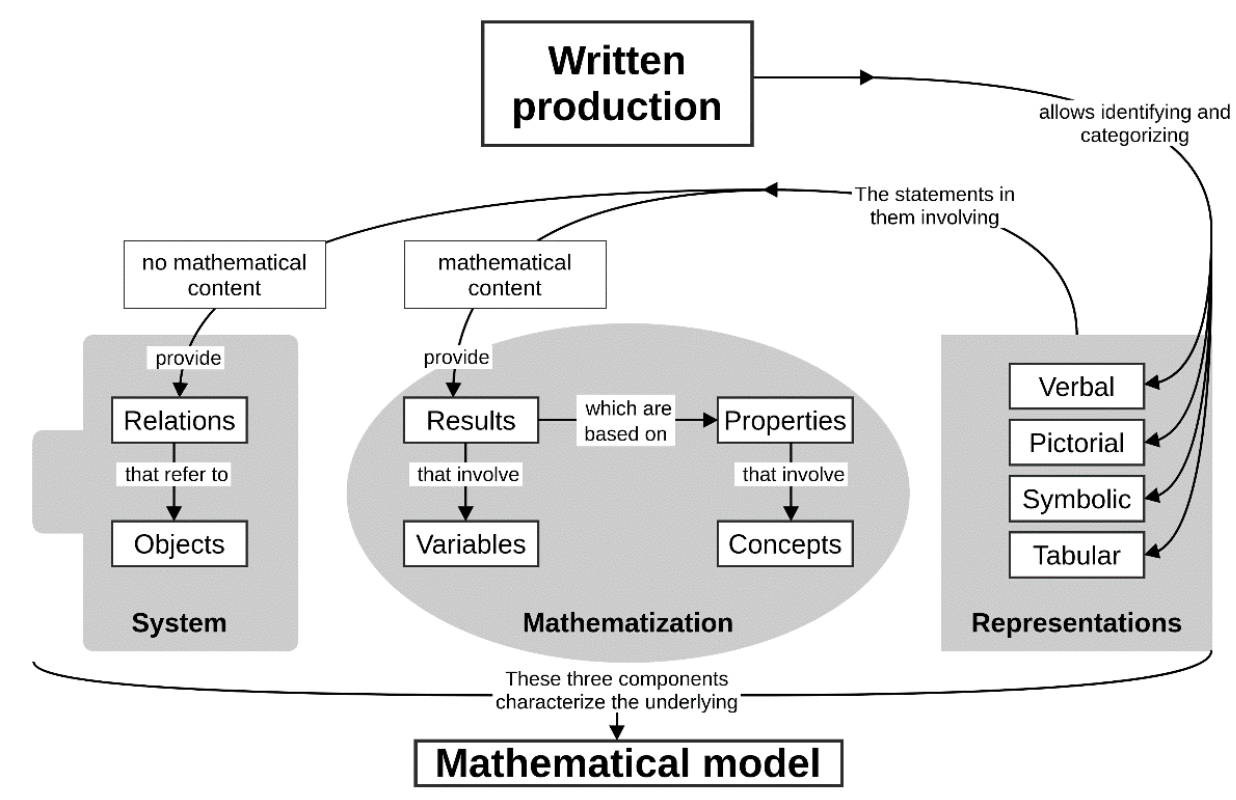
Figure 1. Flux diagram of the analysis procedure for the proposed tool (source: prepared by the authors).